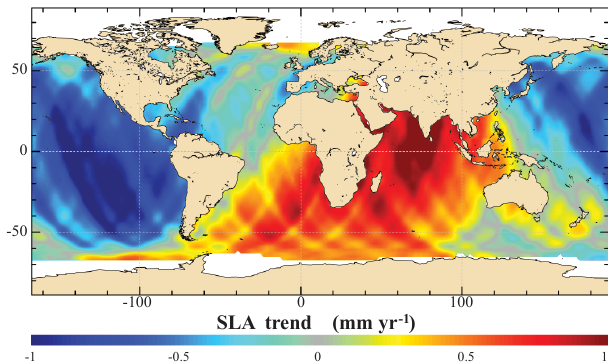
Figure 2. Difference in sea level trends for ERS-1 data (Octo- ber 1992 to June 1996) computed using GFZ VER11 orbit and the REAPER combined orbit (which was used in an earlier CCI sea level product; Ablain et al., 2015).